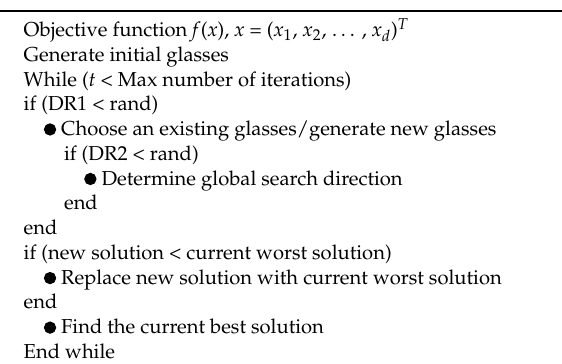
Table 2. Pseudo-code of